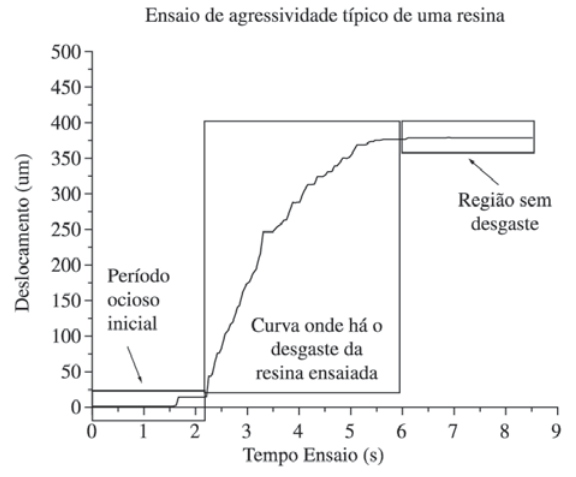
Figura 5. Gráfico mostrando a tangente da curva de desgaste das resinas, a qual seu coeficiente angular é utilizado no cálculo da respectiva agressividade.